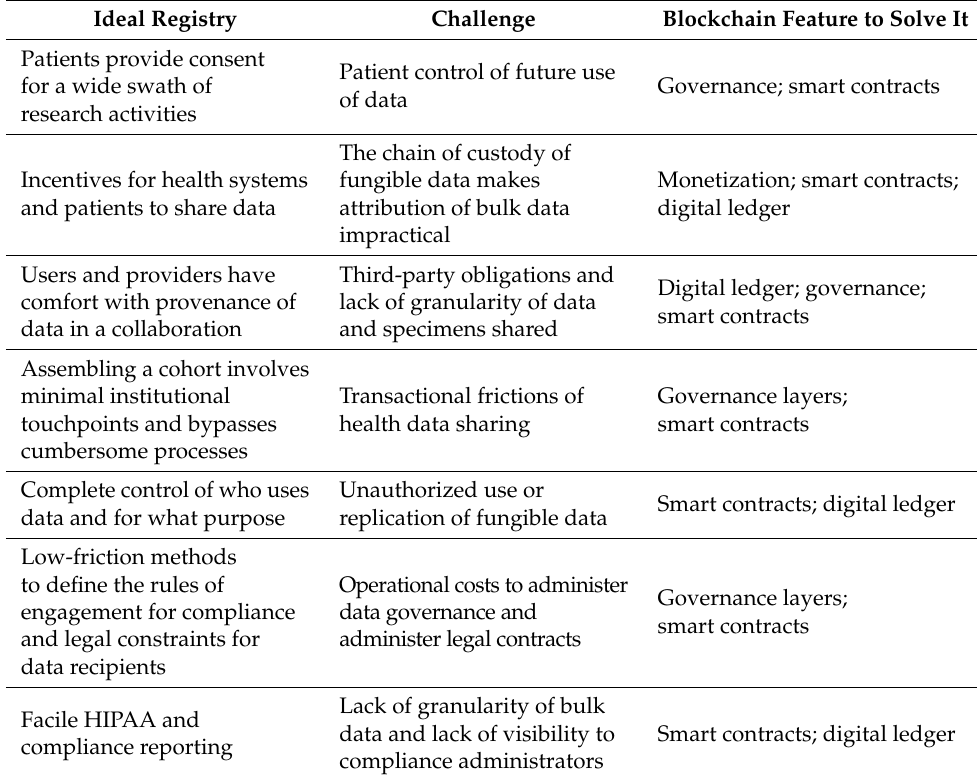
Table 1. Idealized clinicogenomic registry features, challenges to complementation, and features of blockchain technology addressing these